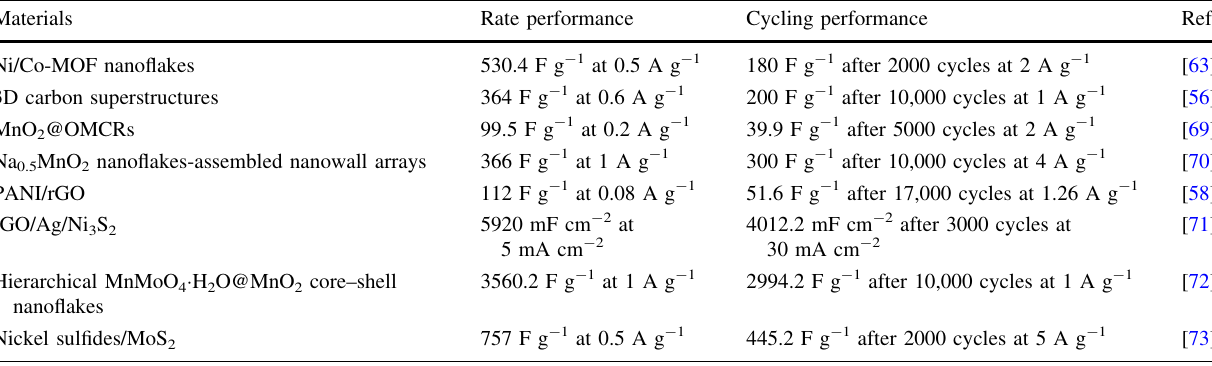
Table 1 Comparison of electrochemical performance of 2D nanoflake ensemble-based materials for supercapacitors Materials Rate performance Cycling performance Refs. Ni/Co-MOF nanoflakes 3D carbon